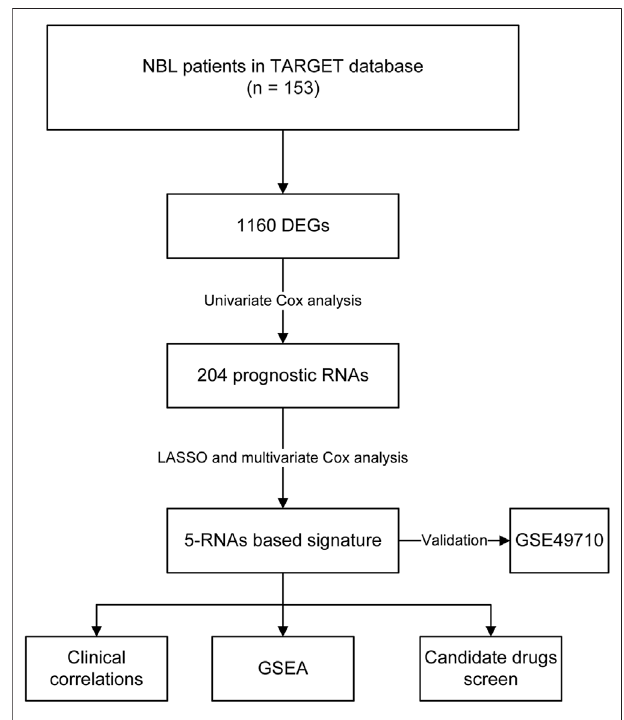
FIGURE 1 | The fl ow chart of constructing a fi ve-RNA based